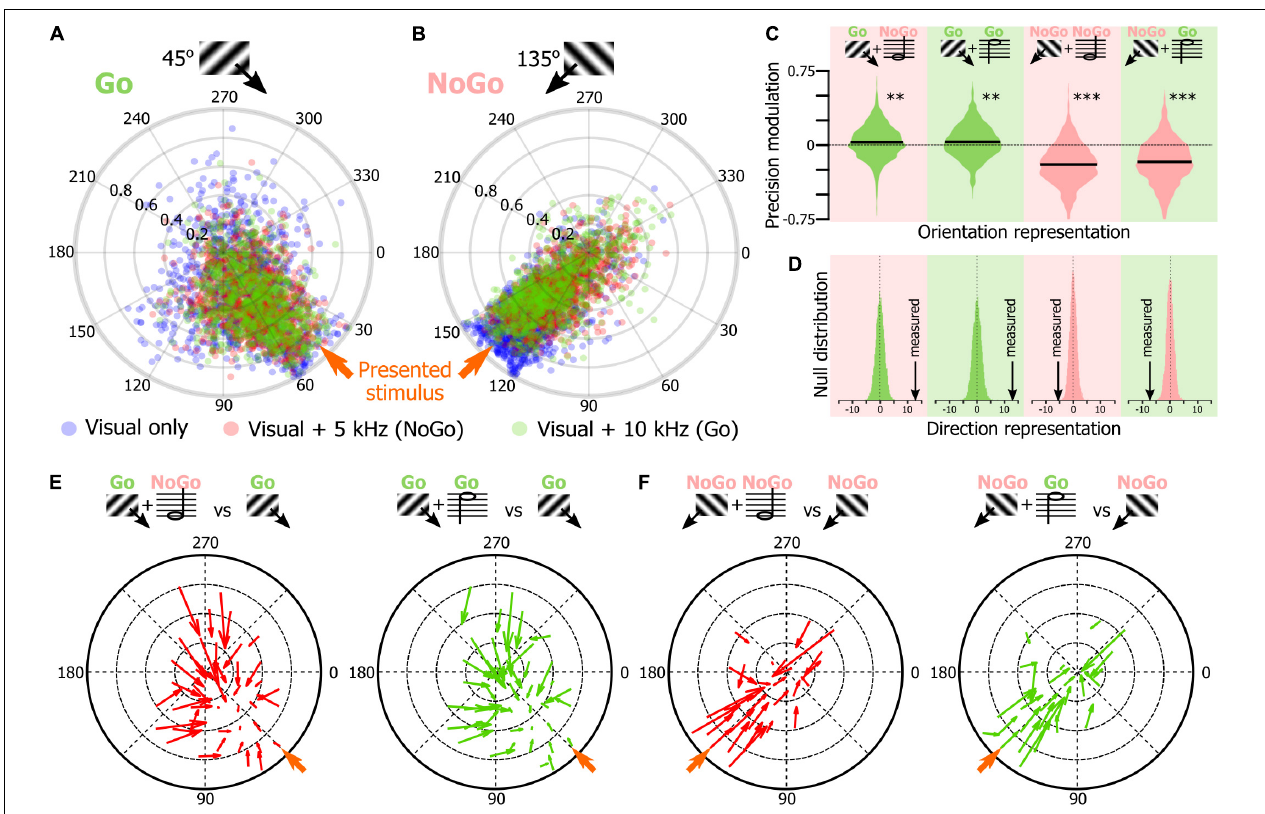
FIGURE 6 | Sound modulation of the V1 population evoked response in mice performing an audiovisual detection task. (A) Output of 1,000 SNNs made of 250 randomly selected V1 neurons to the presentation of a 45 ◦ drifting grating (Go cue) in the unimodal (blue) and audiovisual (5 kHz tone: red, NoGo cue; 10 kHz: green, Go cue) contexts. The orange arrow indicates the orientation of the presented stimulus. (B) Same representation as in panel (A) for the presentation of the 135 ◦ drifting grating (NoGo cue). (C) Modulation by the 5 kHz (red background, NoGo cue) and 10 kHz (green background, Go cue) sounds of the precision indexes of the 1,000 SNNs shown in panels (A,B) . The black bar indicates the mean of the distribution. Random permutation test ( ∗∗ p = 0.002; ∗∗∗ p < 0.0001). (D) Comparison of the proportion of SNN outputs shown in panels (A,B) changing direction when the visual stimulus was presented with one of the two sounds in panels (B,C) together with the probability distribution of the same measure performed 10,000 times with shuffled data (for all panels: p < 0.0001). (E) Quiver plot of topographically clustered modulation vectors illustrating how SNNs with similar outputs for the presentation of the 45 ◦ drifting grating (Go cue) are modulated by the 5 kHz (red, NoGo) and 10 kHz (green, Go) sounds. (F) Same representation as in panel (E) for the presentation of the 135 ◦ drifting grating (NoGo